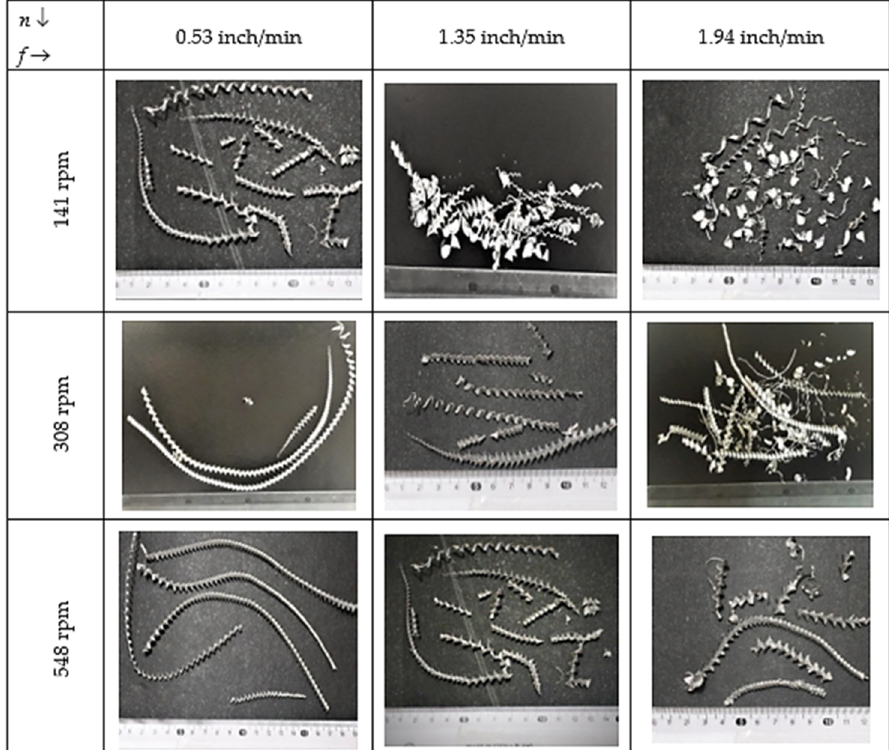
Figure 5. Chip formation at various drilling parameters.